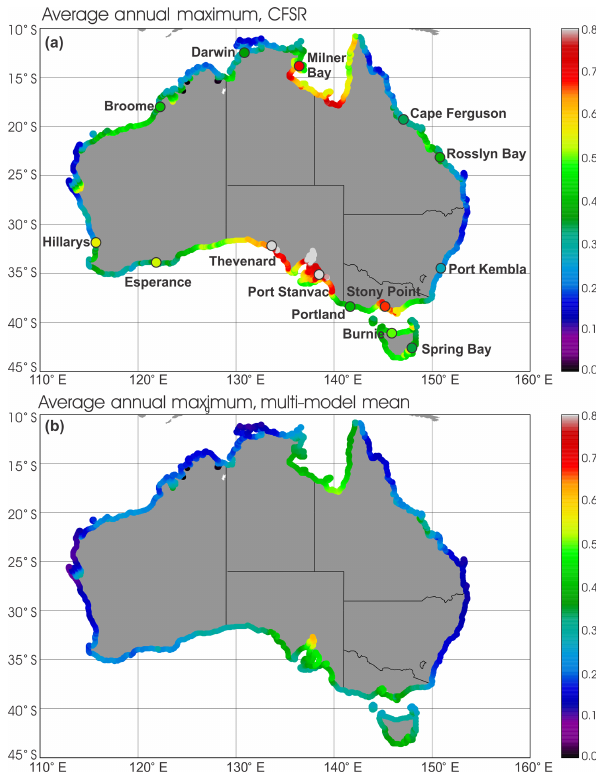
Figure 8. The average annual maximum surge over 1980–1999 from the B-M simulation (a) and the average annual maximum sea level of the four 1980–1999 CC simulations (b) . The values derived from tide gauges over the period 1993–2012 are shown by the large circles (a) . Units are in